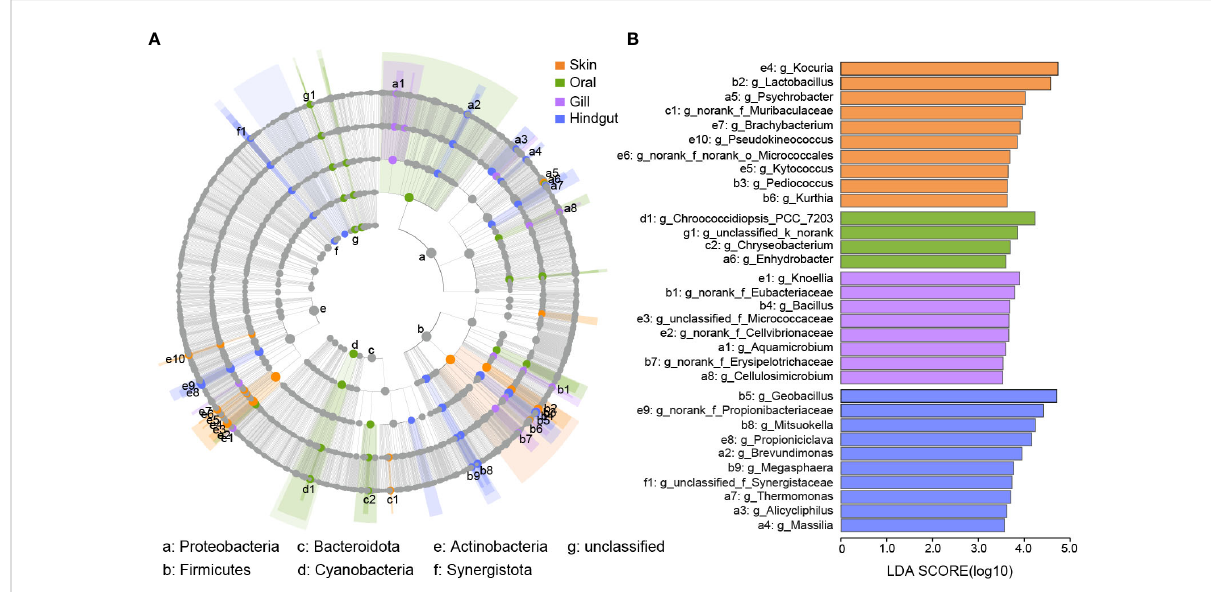
FIGURE 5 Biomarkers in four body sites. (A) Cladogram of the phylogenetic distribution of the bacterial lineages from phylum to the genus in the skin, oral, gill, and hindgut. The diameter of each dot repents the relative abundance. The species with a signi fi cant difference were represented by different colors among the four groups. The grey nodes indicate that there was no signi fi cant difference. (B) Bar plots showed the biomarkers from (A) with an LDA ≥